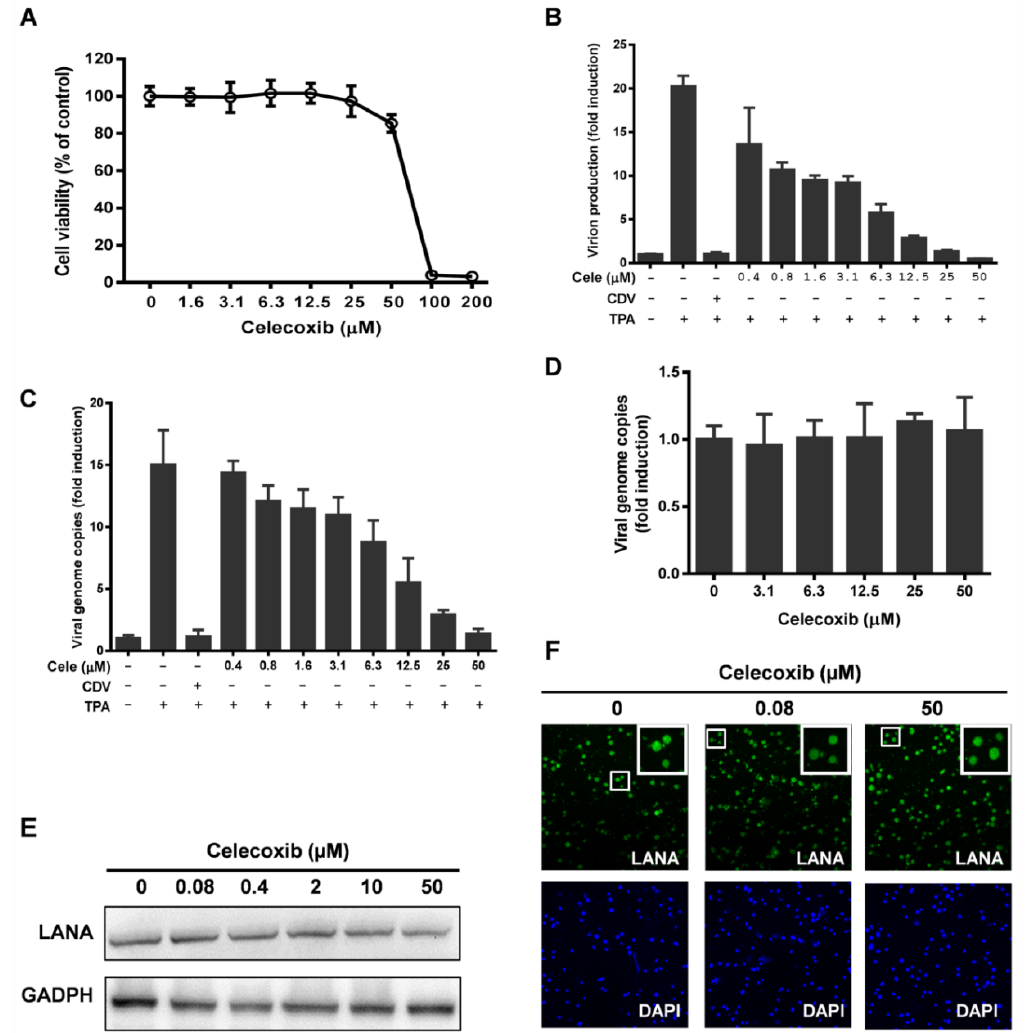
Figure 1. The effects of celecoxib on lytic and latent replication of Kaposi’s sarcoma- associated herpesvirus (KSHV) in BCBL-1 cells. ( A – C ) The effects of celecoxib on lytic replication of KSHV. BCBL-1 cells were lytically induced by TPA for 3h and then exposed to the indicated concentrations of celecoxib (cele) for 72 h; Then, the cell viability was determined by CellTiter-Glo ® Luminescent Cell Viability Assay ( A ); The virion production was determined by quantitative PCR (qPCR) analysis of the viral DNA extracted from equivalent supernatants using primers specific for the KSHV ORF73 gene ( B ); The copy numbers of the intracellular viral DNA were directly extracted from cells and were quantified by qPCR using primers specific for the KSHV ORF73 gene. Then each sample was normalized to the amount of the GAPDH gene ( C ); CDV (20 µM) was used as a positive control; ( D – F ) The effects of celecoxib on latent replication of KSHV. BCBL-1 cells were treated with celecoxib in the absence of TPA for 72 h. Then, the intracellular viral DNA copies was measured by qPCR ( D ), LANA protein expression were detect by Western blotting ( E ) and indirect immunofluorescence assay ( F ) using anti-LANA as described in Methods; Data in ( B ) and ( C ) were normalized as the fold change compared with the TPA non-induced control; Data in ( D ) were normalized as the fold change compared with DMSO treatment control. The results are presented as the mean values with standard deviations ( n =